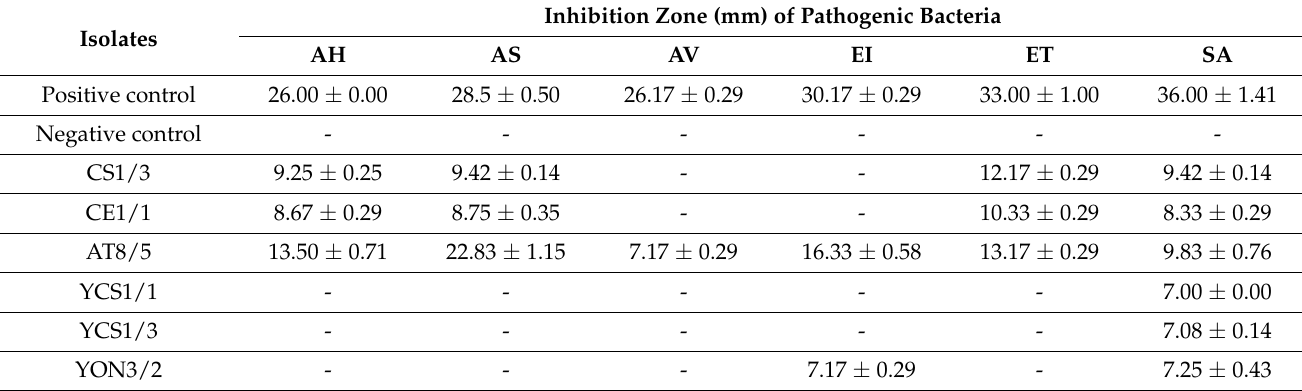
Table 3. Antibacterial properties of selected isolates by using agar slab assay (Mean ± SD).